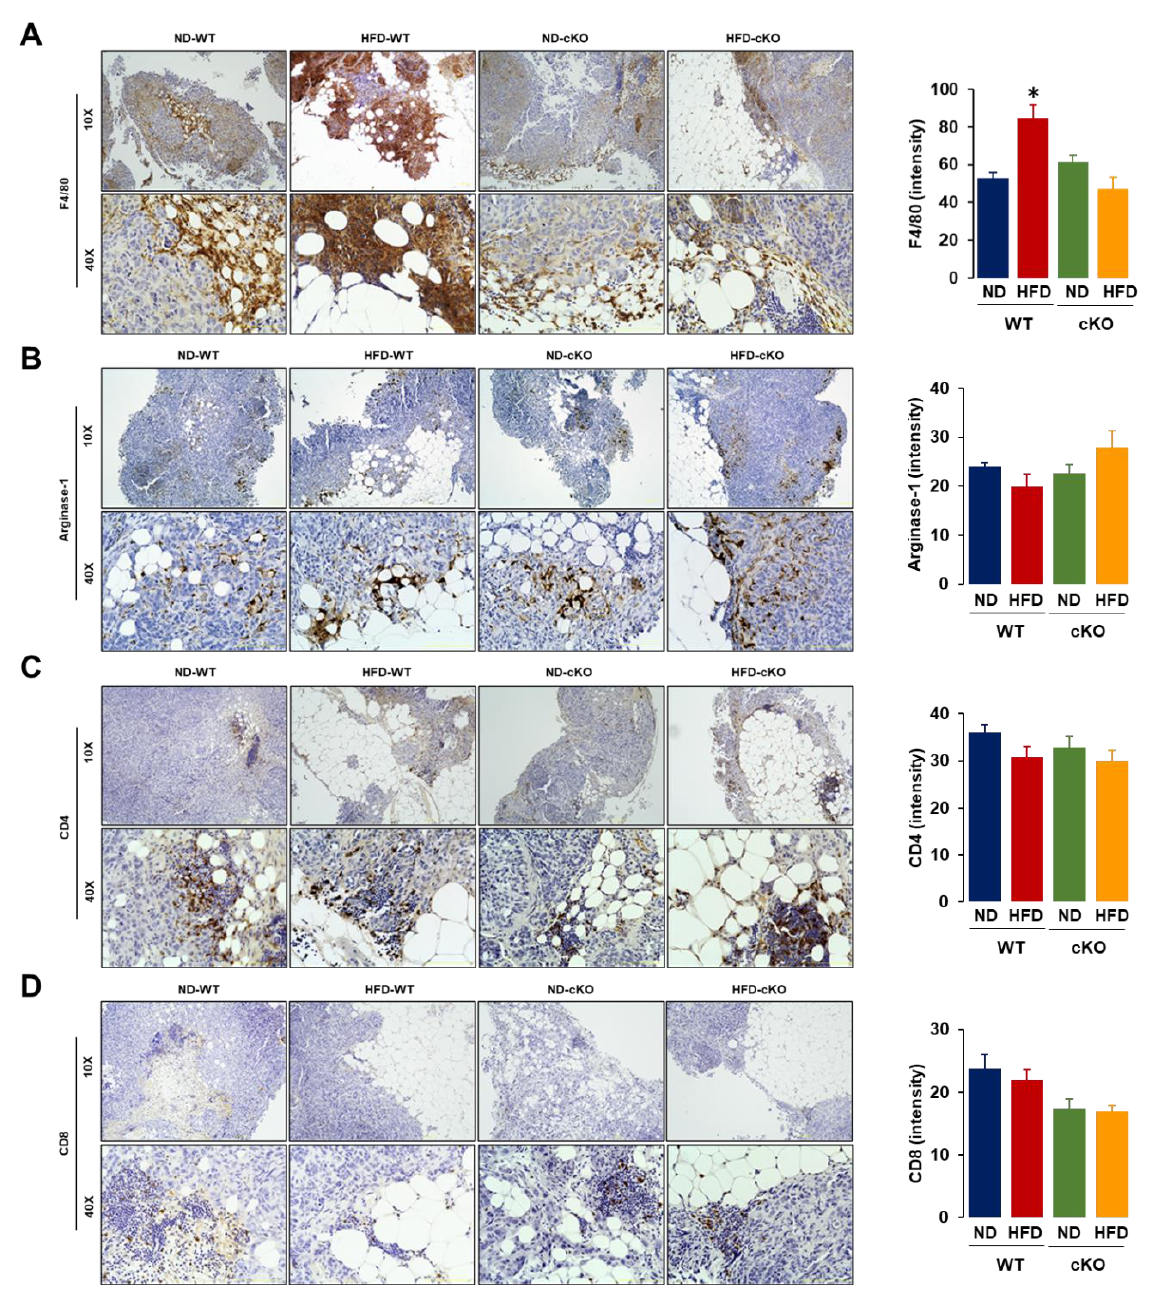
Figure 6. Immunohistochemical evaluation of immune cells in omental tumor tissues from a postmenopausal diet-induced obese mouse model between CXCR2 WT and cKO mice. Histological features of (A) F4/80-, (B) arginase-1-, (C) CD4-, and (D) CD8-positive cells in omental tumors from ND-WT, ND-cKO, HFD-WT, and HFD-cKO mice. Quantitative analysis of immune cell disposition was performed using ImageJ with brown color selection through color deconvolution of hematoxylin and DAB staining followed by intensity analysis. Quantitative analysis was obtained from 3 – 5 random fields of each slide (10×). * indicates a significant difference ( p ≤ 0 .05) between groups as analyzed by ANOVA and Tukey’s pairwise comparison tests.